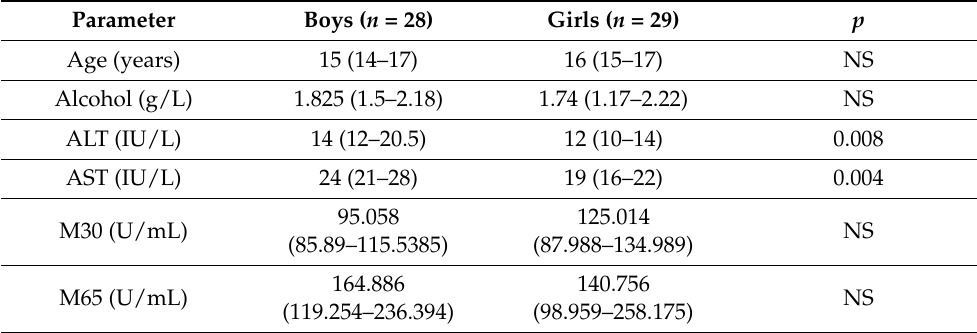
Table 2. Characteristics of the study group in terms of gender: alanine aminotransferase (ALT), aspartate aminotransferase (AST), not significant (NS).